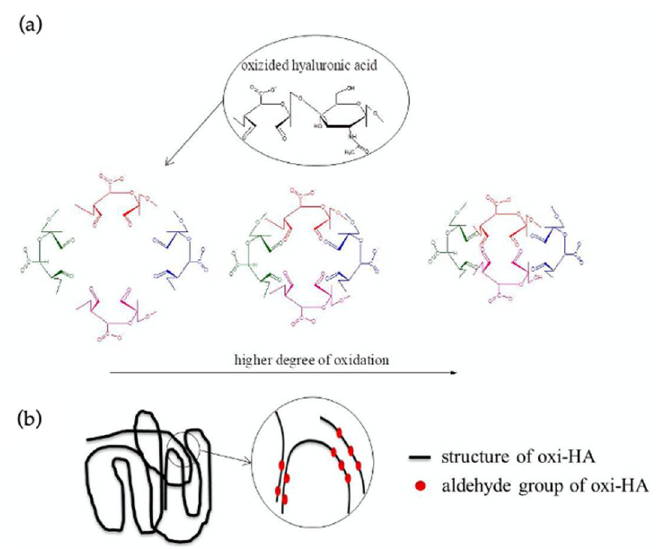
Figure 3. ( a ) Approximation of the aldehyde groups of oxi-HA with increasing degree of oxidation and ( b ) modified entanglement and cross-linking.